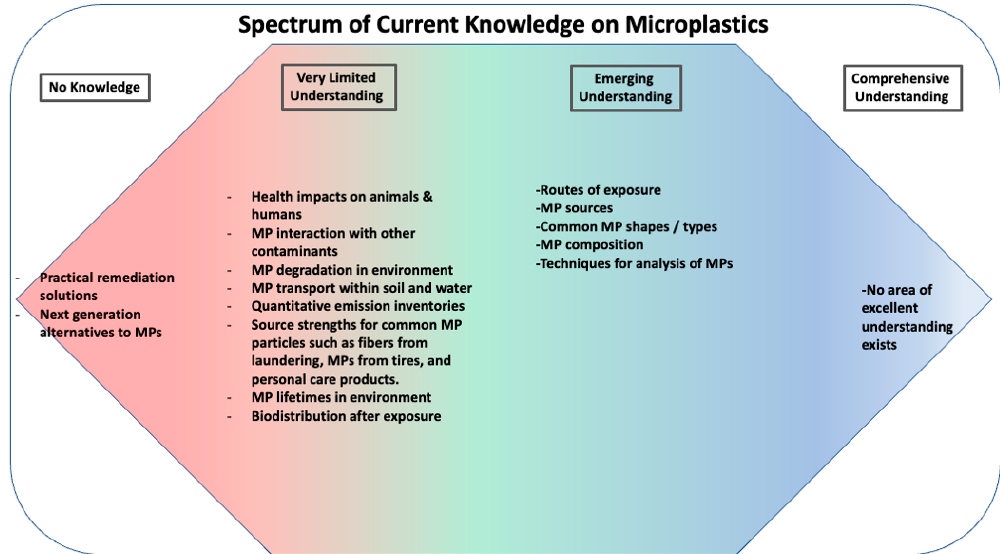
Figure 12. Spectrum of current knowledge regarding microplastics.